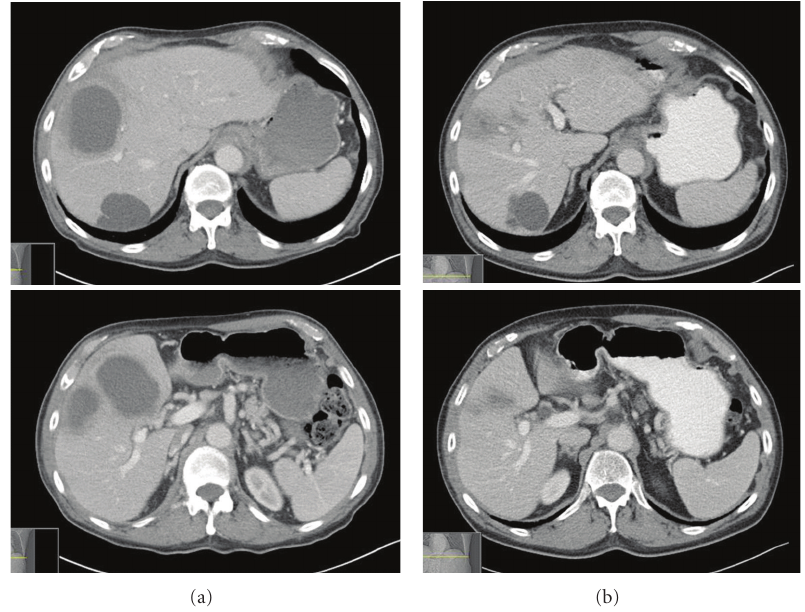
Figure 1: Abdominal CT images showing multiple liver abscesses before treatment (a) and resolution after treatment (b). Of note, patient has a benign liver cyst posteriorly that remained unchanged.